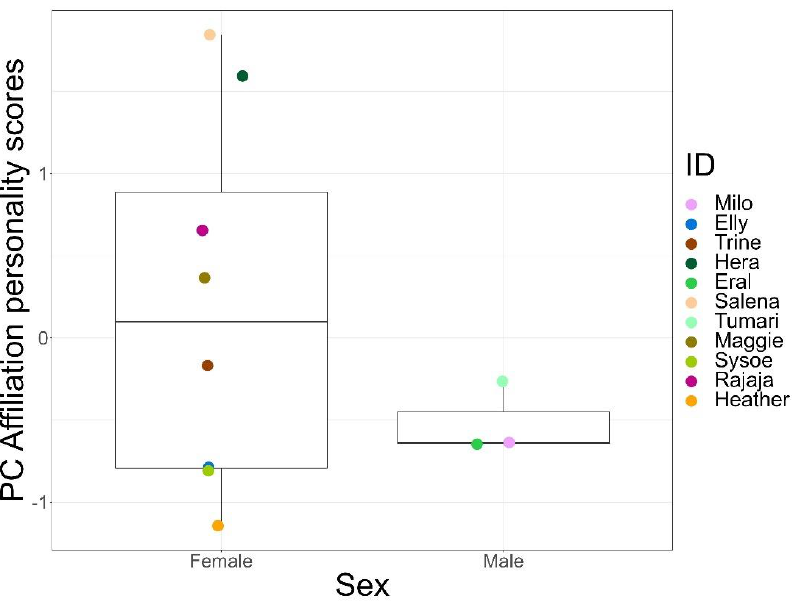
Figure 2. Personality scores for the affiliation component of females and males. Different coloured dots indicate individuals. Individual personality scores are given in Table 3. Table 3. Personality scores of all individuals for the persistence, sociability, affiliation, and anxiety components.